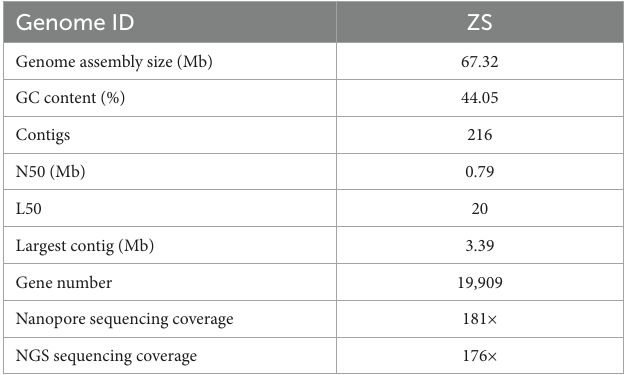
TABLE 1 Statistics of assembly of the DI